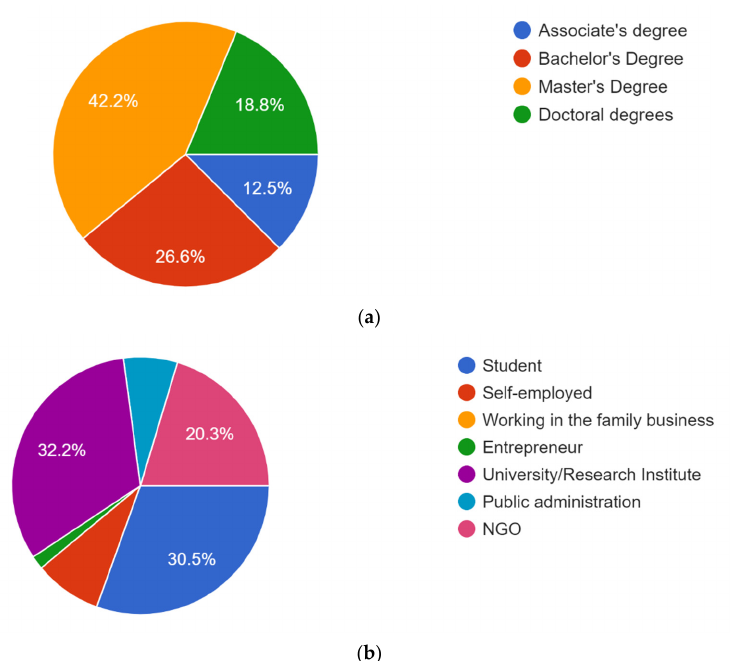
Figure 2. ( a ) RRs’ educational level; ( b ) RRs’ working sector.